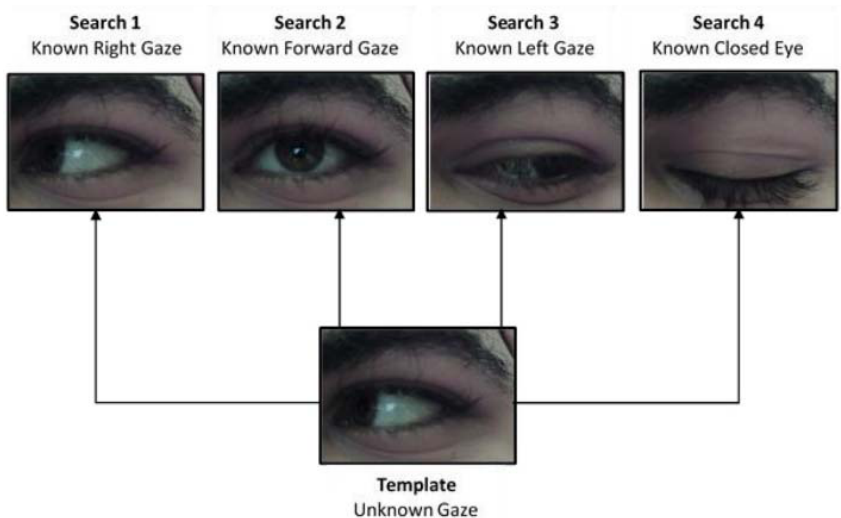
Figure 7. Gaze estimation using template matching.